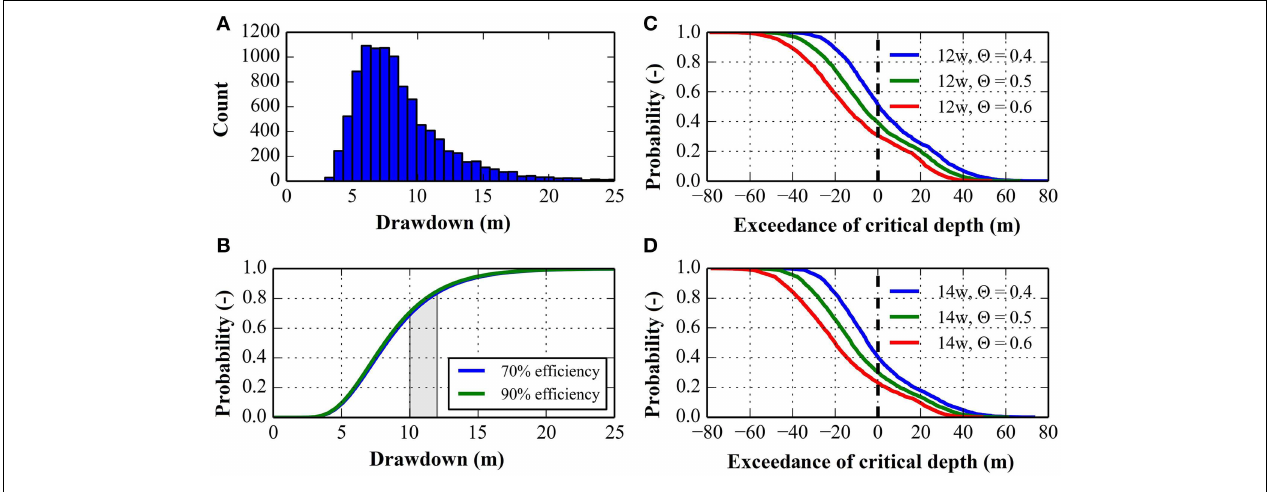
FIGURE 10 | Results of the hydrogeological assessment. (A) Histogram of calculated drawdown values, (B) cumulative probability distribution of calculated drawdown, (C) cumulative probability distribution of the fresh-saline water interface exceeding the critical